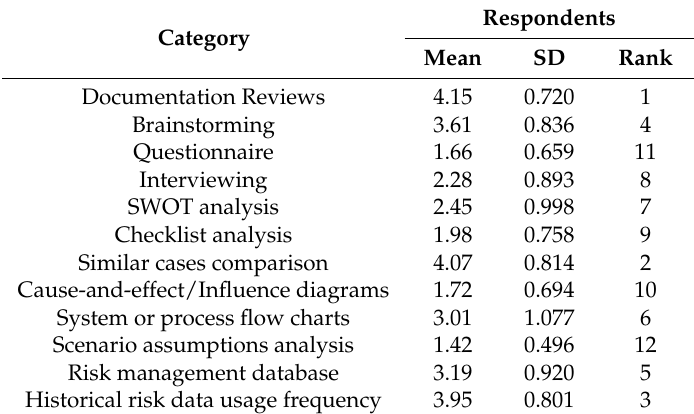
Table 6. Risk identification tools used by the companies.